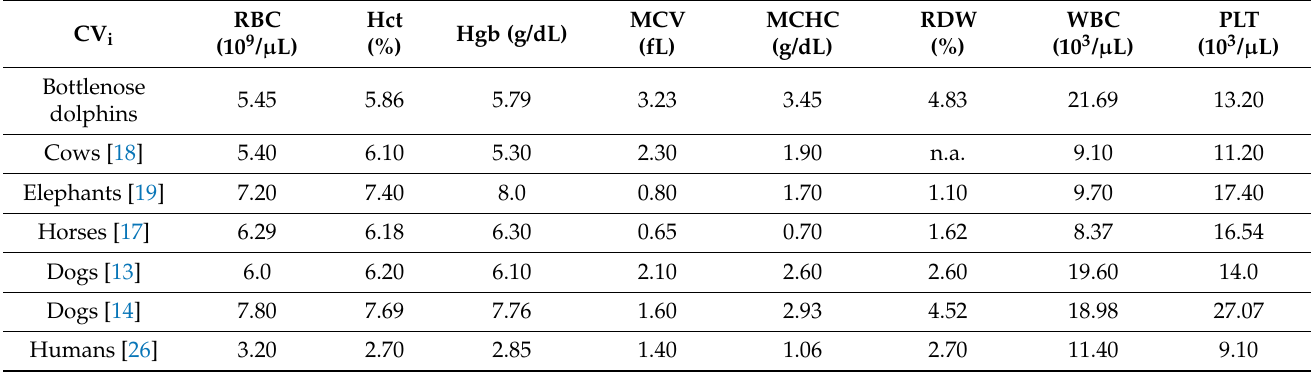
Table 4. Comparison of within-animal coefficient of variation (CV i ) for hematological measurands in different species. RBC = number of erythrocytes, Hct = hematocrit, Hgb = hemoglobin, MCV = mean cellular volume, MCHC = mean cellular hemoglobin content, RDW = red blood cell distribution width, WBC = number of leukocytes, PLT = number of platelets, n.a. = not